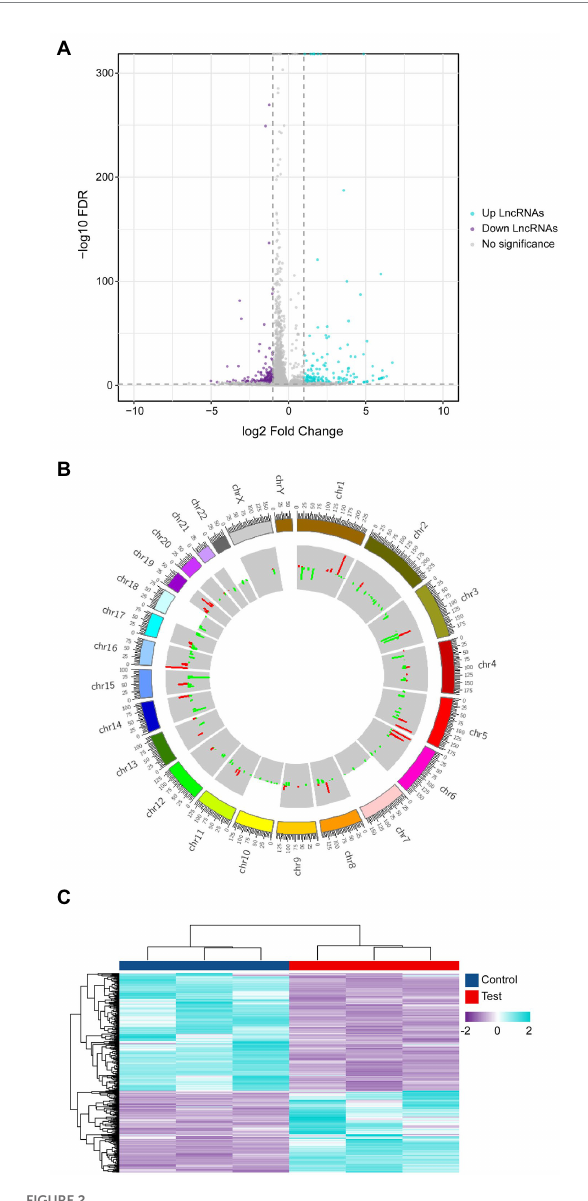
FIGURE 2 Differential analysis of lncRNA expression profiles. (A) Differential lncRNAs volcano plot: the plot’s horizontal and vertical axes reflect Log 2 (Fold change) and -Log 10 (Q. Value), respectively. We determined the importance of Log 2 | (Fold change) | ≥ 1, Q. Value < 0.05 as the cut- off criterion. (B) Localization of differential lncRNAs chromosomes: the inner and outer circles of the circos plot were used to represent up- regulated and down-regulated genes, respectively, with |Log 2 (Fold change) | ≥ 1, Q. Value < 0.05 as the cut-off criterion and the fold change in expression was represented by column height. (C) Heat map of expressed lncRNAs cluster analysis: each column represents control and experimental groups The horizontal axis symbolizes each column of experimental groups. The hue indicates the expression level of each sample group. The tint transitions from violet to blue as the level of expression increases.